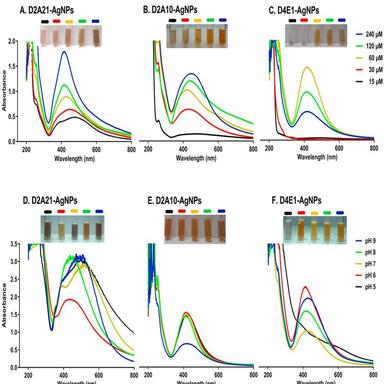
UV–visible absorption spectra of peptide-based silver nanocomposites (P-AgNPs). Optimization of P-AgNPs synthesis by suitable peptide concentration (A–C) and suitable pH (D-F) at constant 1 mM AgNO3. The peptide concentration used for D–F was 240 μM for D2A21 and D2A10; 60 μM for D4E1. All spectra were recorded after 5 days of incubation at 25 ± 2 °C (room temperature).